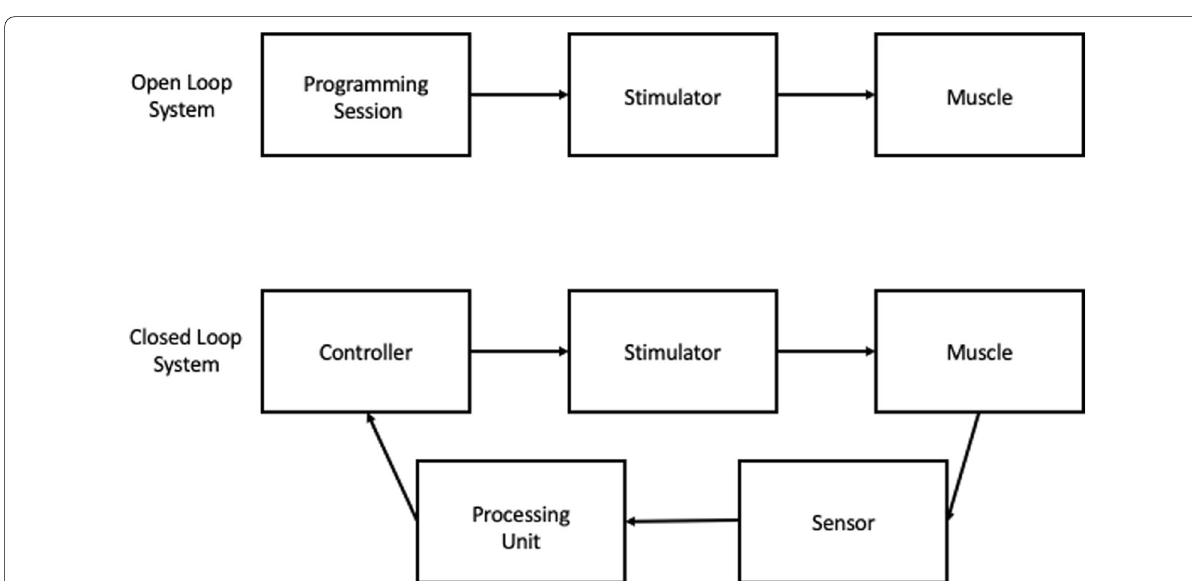
Fig. 3 Closed and open loop systems. Open loop systems do not provide feedback. Closed loops systems have a feedback loop that continuously sends information back to the controller to